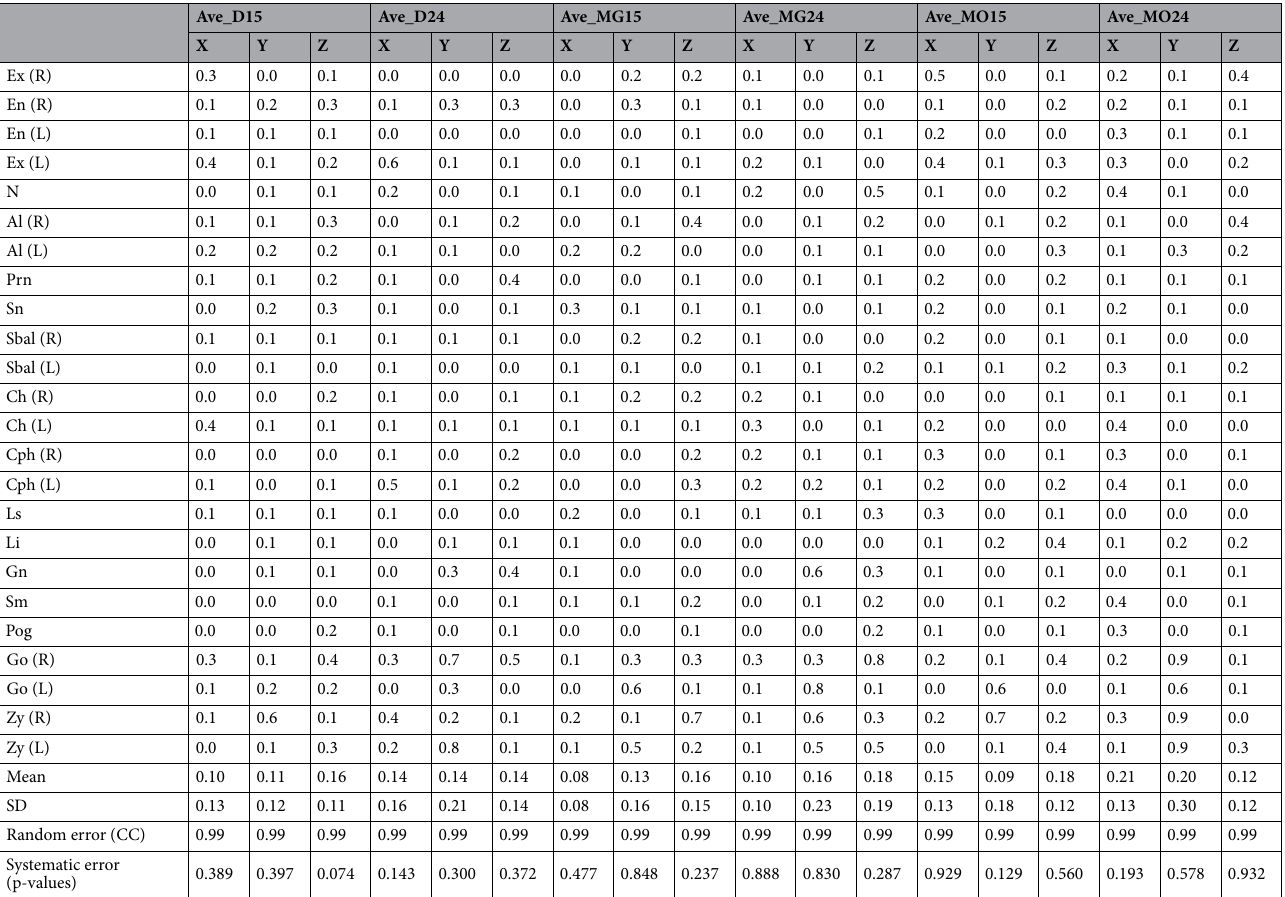
Table 2. Each of the four images (average faces) were landmarked twice, 2 weeks apart, and the differences in landmark coordinates between the first and second digitisation were used for analysis of the errors of the method. Systematic error was assessed by using a paired t-tests and random error assessed by coefficients of